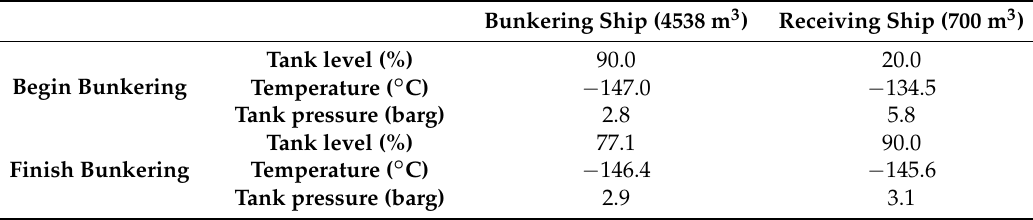
Table 4. Conditions for the bunkering and receiving ships.